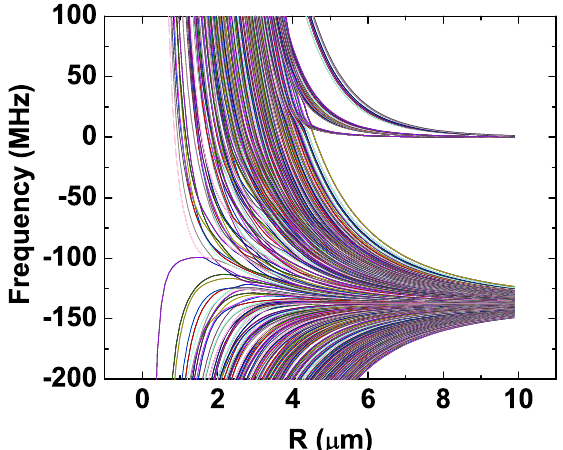
Figure 4. Four atoms are located at the four vertices of a tetrahedron, and one atom is located at the center of the tetrahedron. Two groups of levels are shown. For the top group, there are four 40 s atoms and one 41 s atom, and there are three 40 s atoms and two 40 p 3/2 atoms in the bottom group. The horizontal axis is the side length of the tetrahedron. The detailed calculation can be found in Reference [31].